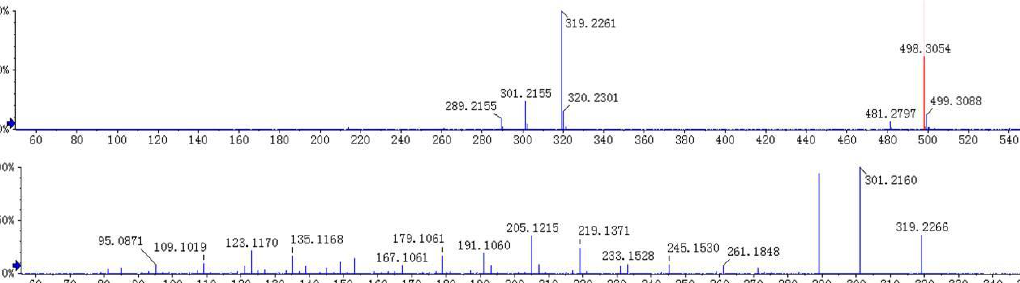
Figure 5. MS/MS spectra of neoandrographolide ( 3 ).